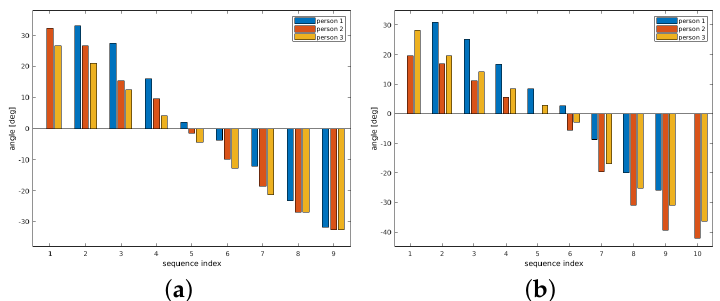
Figure 10. B1 bone—yaw rotation. The registration results compare reference parameters with the extrinsic average bone within full body tissue. ( a ) Original yaw rotation B1, comparison of all three probands. ( b ) Registration against average bone within the full body tissue.